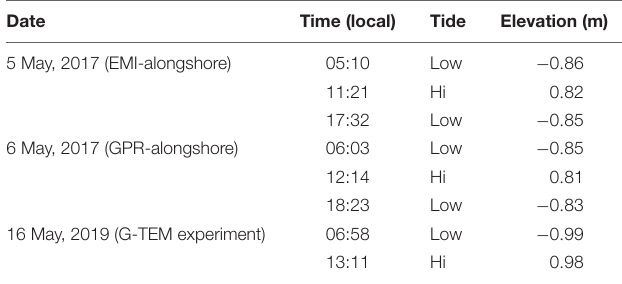
TABLE 2 | Predicted tides at the study site (44 ◦ 00 (cid:48) 58.59 (cid:48)(cid:48) S, 171 ◦ 53 (cid:48) 21.53 (cid:48)(cid:48) E) during the duration of the EMI, GPR, and G-TEM